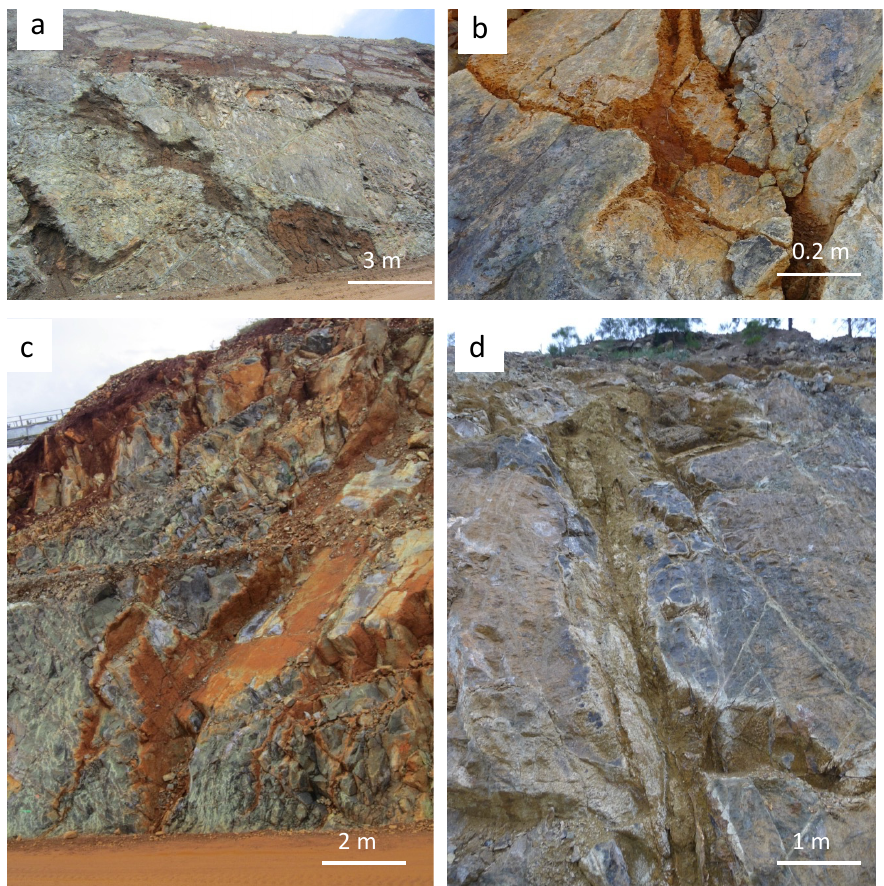
Figure 2. Dissolution pipes in the peridotite (main mining track at Koniambo). ( a ) Network of dissolution pipes near the high of the plateau. ( b ) Detail of the dissolution, which leaves only iron hydroxides as a coating on the edges of the pipe. ( c ) Vertical extension of the dissolution cavities (main track). ( d ) Dissolution along serpentinised fractures.